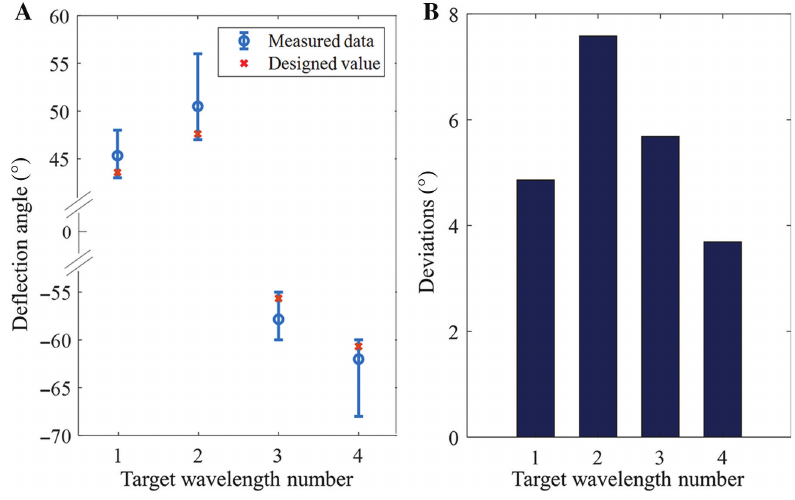
Figure 5: Measurement results. (A) Measured deflection angles (blue circle marker) with error bar for four target wavelengths. Target wavelength numbers 1–4 represent the case of designed wavelengths 1344, 1400, 1610, and 1700 nm, respectively. Red cross markers indicate the deflection angles at each of the designed wavelengths. (B) Deviation of the measured angles for each target The efficiency of each deflected light is calculated from conditions and the spacer thickness optimization (see Figure 4C with reference data, which is 5.75%, 4.46%, Supplementary Information). The dielectric thickness 7.49%, and 1.44%. Although the absolute value of effi- deposited by sputter equipment is slightly smaller than ciency has been considerably reduced overall, the the target 80 nm, which leads to red shift in wavelength.